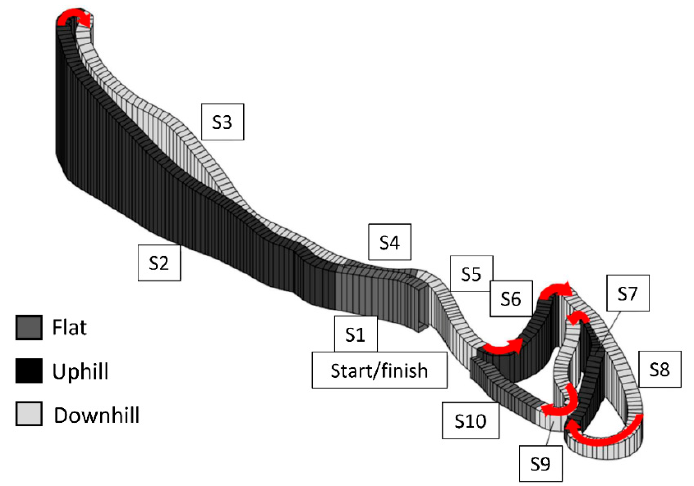
Figure 1. The 2.5 km XC skiing race course divided into the 10 segments according to the elevation difference, including three uphill, three flat, and four downhill segments. Six turns were distributed over the 2.5 km lap (red arrow). With different placement of the start and finish, there is a gap in the 2.5 km course, which was removed from the analyses. (S) Segment (length (meter), incline range (%)); S1: 131 m, − 2.6–1.6%; S2: 543 m, 1.7–12.4%; S3: 509 m, − 11.7–0.2%; S4 100 m, 0.7–2.8%; S5: 156 m, − 6.0–0.0%; S6: 166 m, 1.3–12.7%; S7: 339 m, − 8.5– − 0.4%; S8: 200 m, 1.2–16%; S9: 183